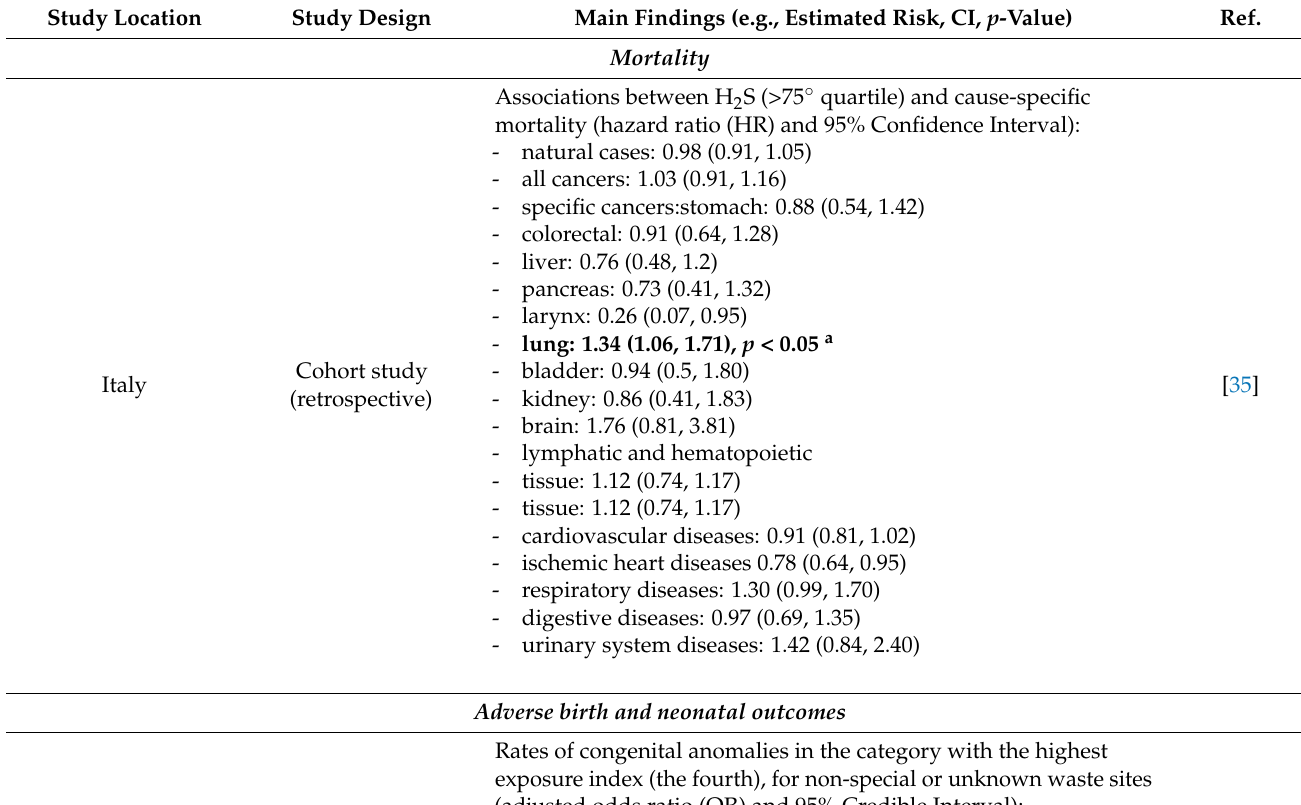
Table 2. Health outcomes associated with